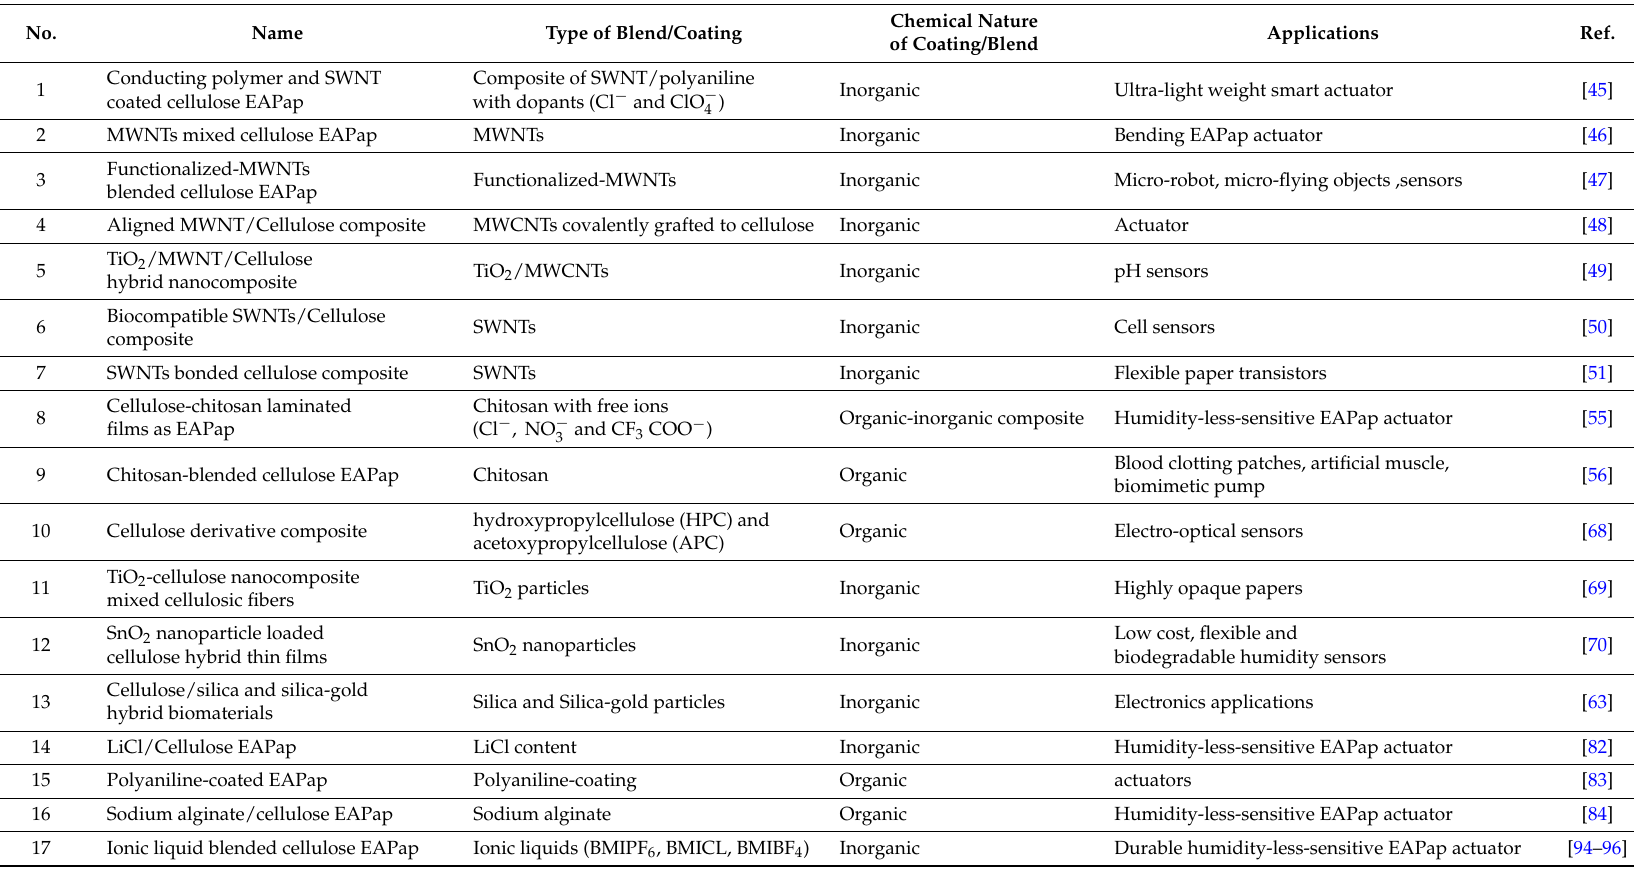
Table 1. Summary of cellulose-based composites, type of blend/coating, chemical nature (organic/inorganic) and potential applications.